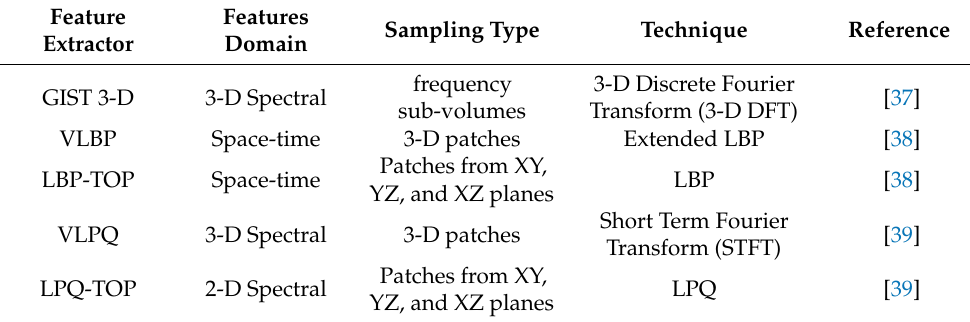
Table 2. Summary of the bona fide